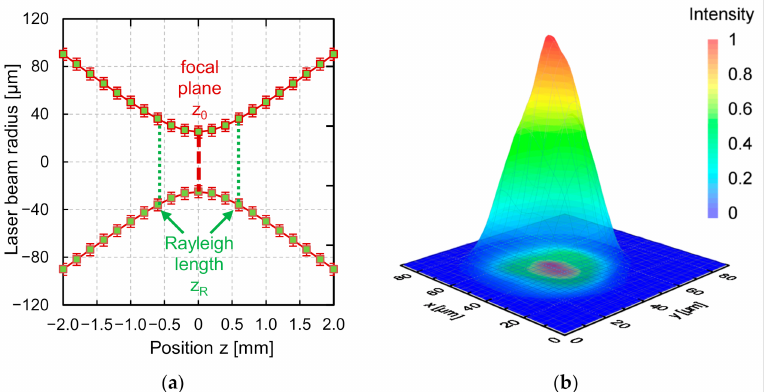
Figure 2. ( a ) Laser beam radius as function of distance to the focal lens (close to the focal plane), and ( b ) 3D representation of intensity distribution of laser beam in focal plane ( d L = 50 µ m).